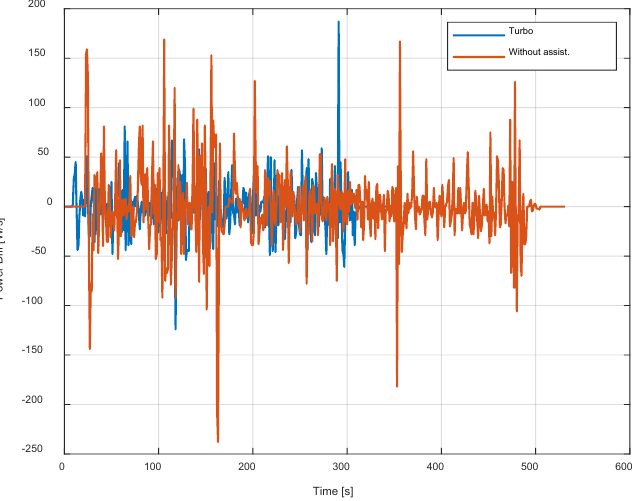
where —crank length; —angular speed of the crank averaged per revolution ( T — period of one revolution); —averaged force on pedals ( N —number of samples per rev- 𝑙𝑙 𝑐𝑐 𝜔𝜔 𝜏𝜏 olution). 𝐹𝐹 𝜏𝜏